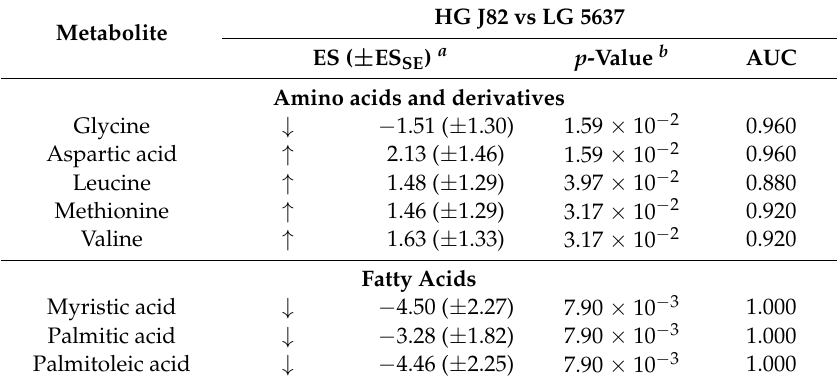
Table 1. List of metabolites selected as important for the discrimination between HG (J82) and LG (5637) bladder cancer cells. Values for ES, ES SE , p , and AUC are indicated for each metabolite.